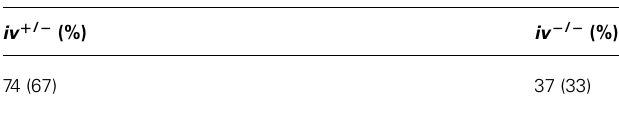
Table 2 | Observed rates of allele frequencies: iv allele, iv + / − × iv − / − . iv + / − (%)